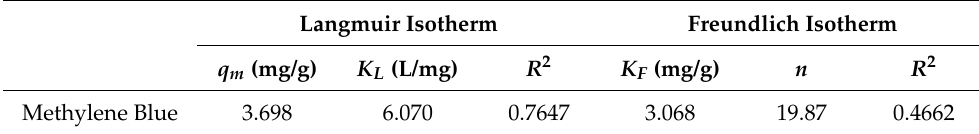
Table 2. Langmuir and Freundlich isotherm constants and values of MB adsorption on GO/PLA. Langmuir